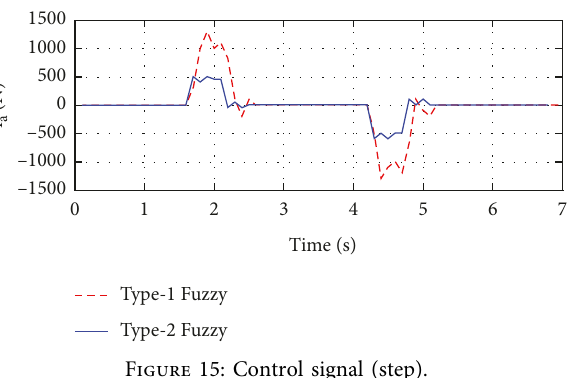
Figure 14: Body acceleration (step).